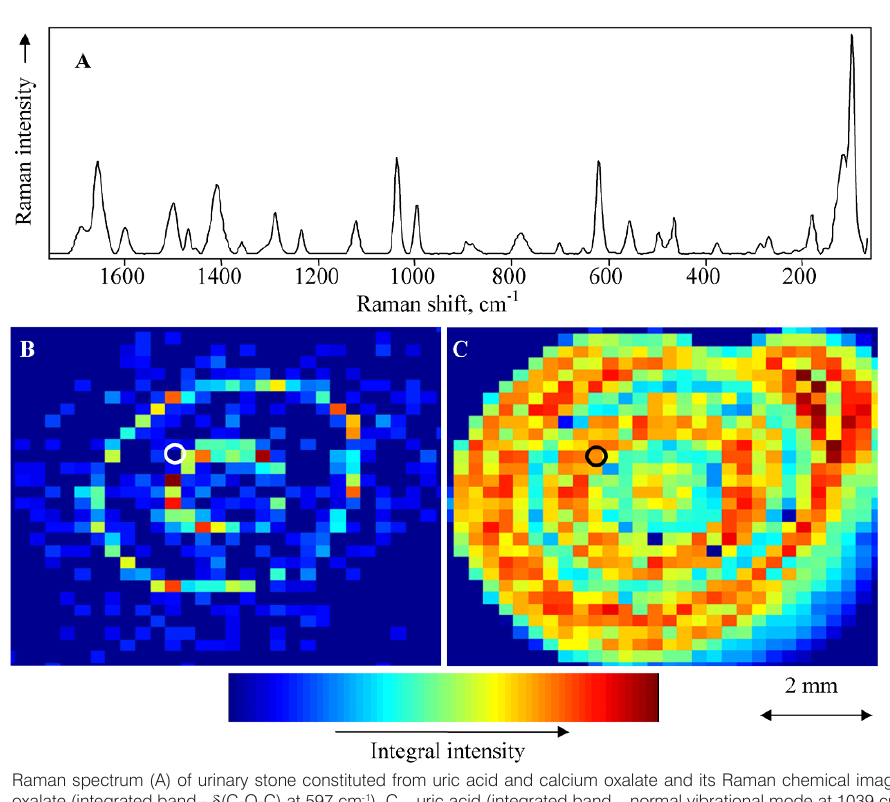
Figure 6. Raman spectrum (A) of urinary stone constituted from uric acid and calcium oxalate and its Raman chemical images: B – calcium oxalate (integrated band - δ (C-O-C) at 597 cm -1 ), C – uric acid (integrated band – normal vibrational mode at 1039 cm -1 (boxed in A)) [25]; the white/black circle designates the area where the presented spectrum (A) was recorded; red color designates the highest, blue – the smallest (or lack of) concentration of a